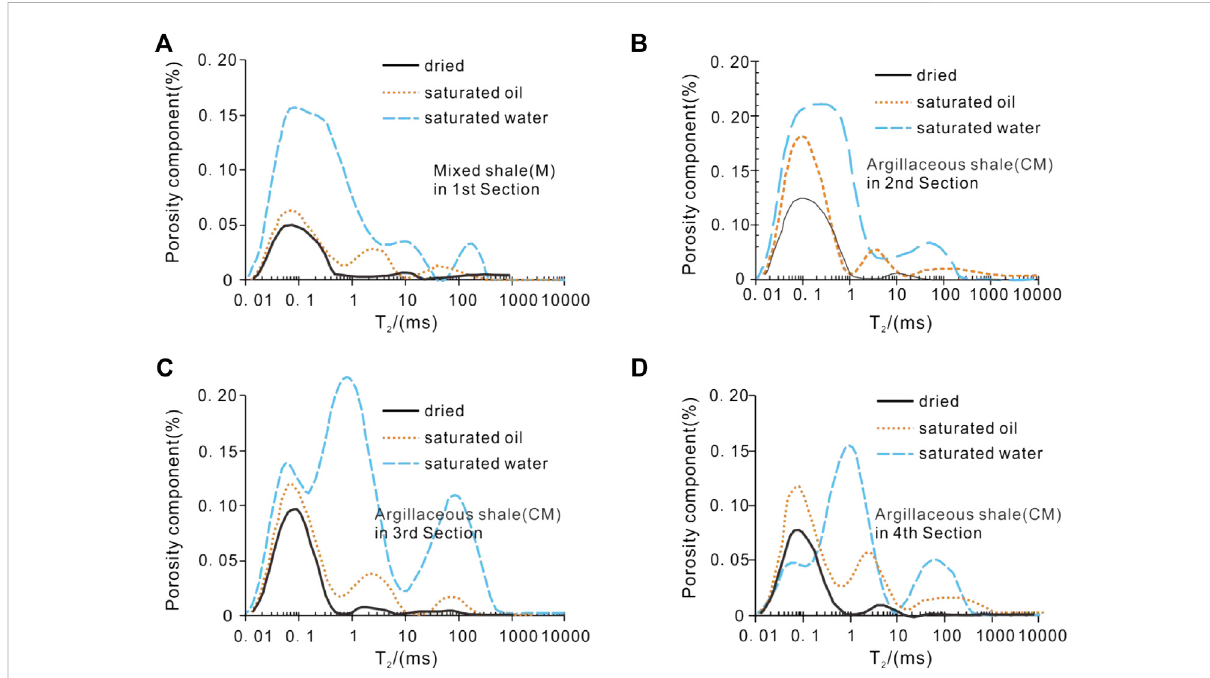
FIGURE 4 NMR T 2 spectra of different shale lithofacies under different states for the Jurassic Dongyuemiao lacustrine shale in Eastern Sichuan Basin.